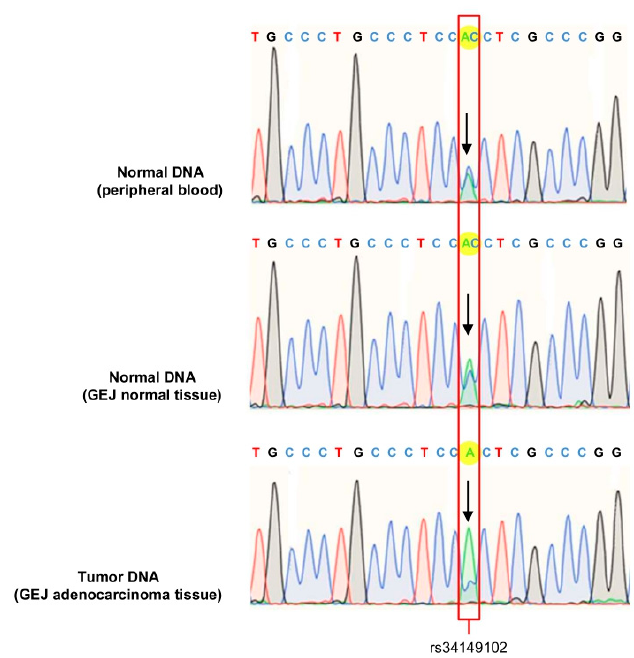
Figure 4. Sanger sequencing electropherograms of the region around the PTEN rs34149102 locus in normal DNA (peripheral blood and GEJ normal tissue) and tumor DNA (GEJ adenocarcinoma tissue), showing the loss of the PTEN rs34149102 major C allele in tumor tissue .